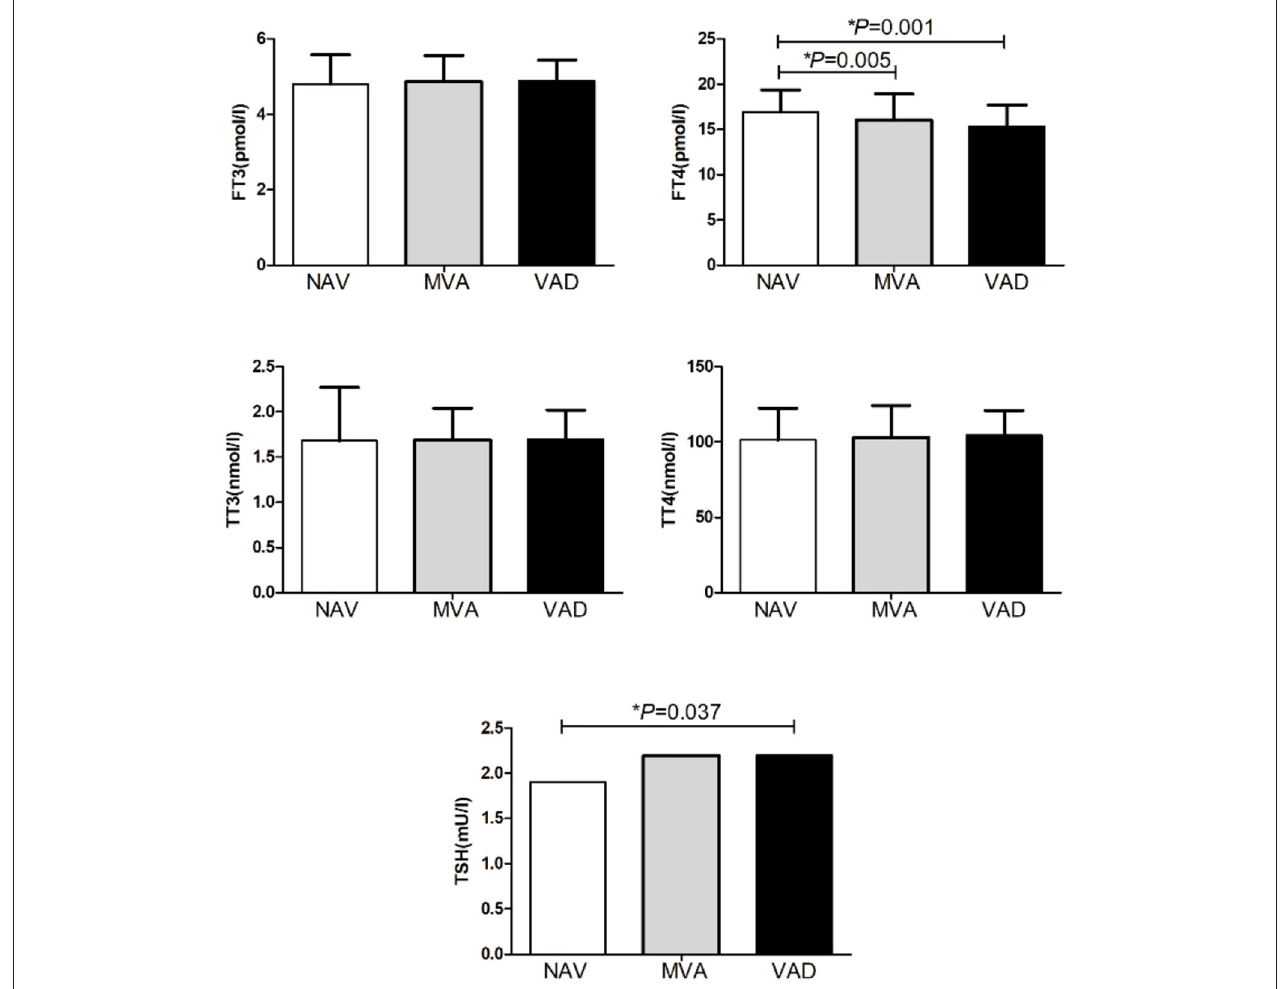
FIGURE 3 | Comparison of thyroid hormone among obese patients with different degree of VA.